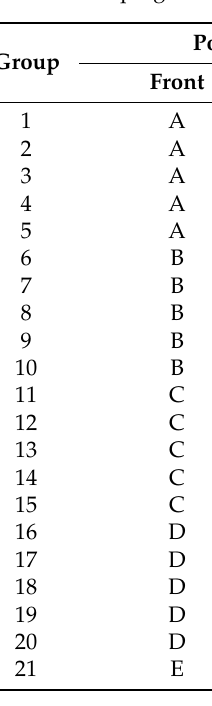
Table 10. Groupings and data recording for test